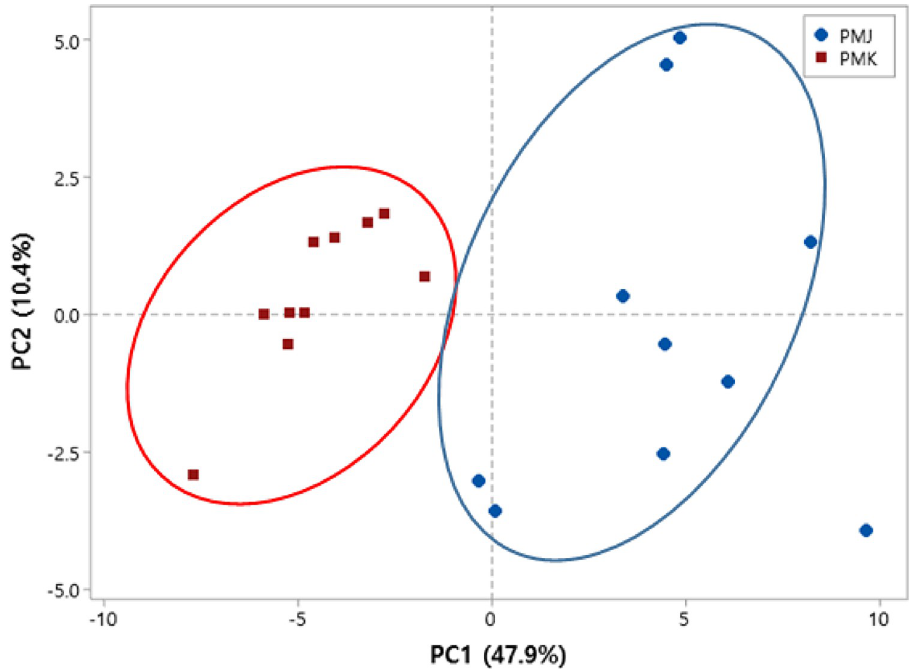
Fig 1. Principal component analysis of metabolome data from Japanese (PMJ, n = 10) and South Korean (PMK, n = 10) red seabream muscle samples. PMJ: Japanese red seabream (n = 10).